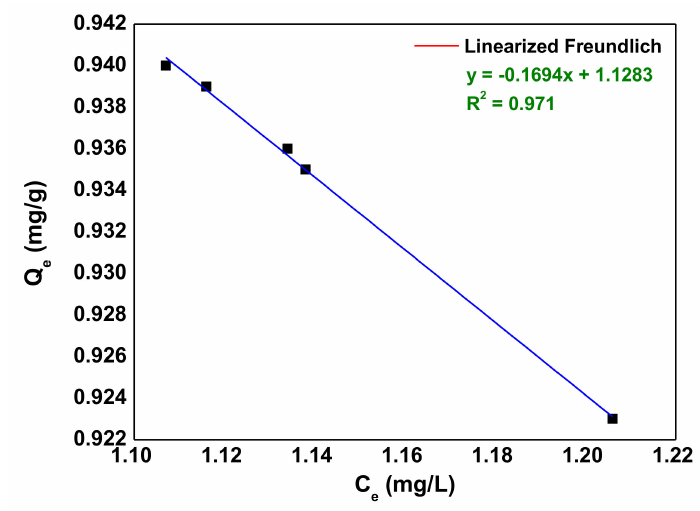
Figure 11. Linear Freundlich isotherm of AB92 adsorption onto Nd 2 O 3 nanoparticles.